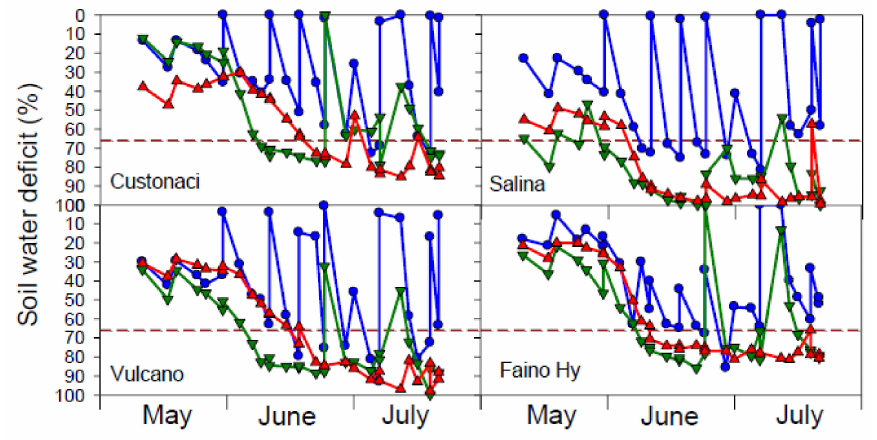
Figure 2. Soil water deficit measured at a depth of 0.40 m in each irrigation treatment (blue line: IRR; green line: REW; red line: DRY). Constant horizontal short dash line indicates minimum threshold of available soil water